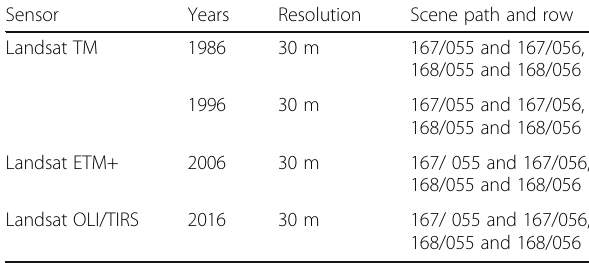
Table 1 Landsat satellite series used for landscape change Sensor